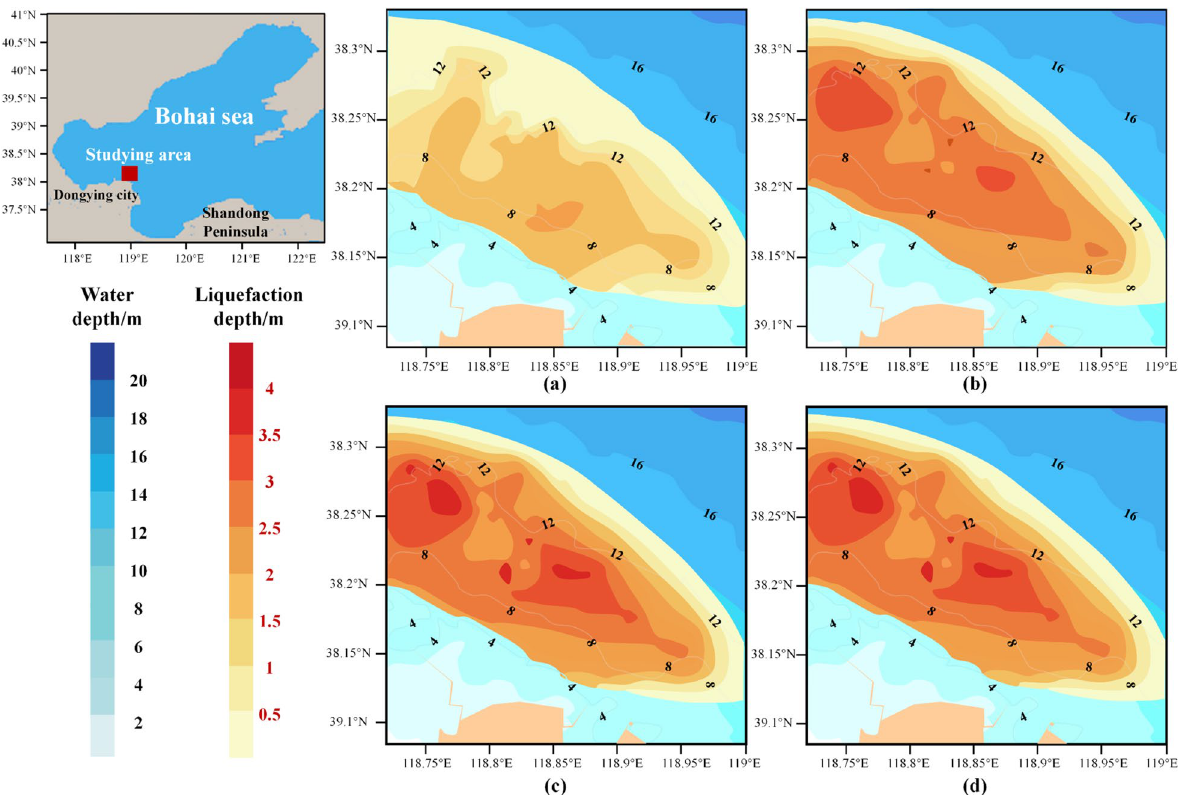
Fig. 13 Potential liquefaction depth of the seabed in different wave recurrence intervals: a wave recurrence period is 2 a; b wave recurrence period is 10 a; c wave recurrence period is 25 a; ( d ) wave recurrence period is 100 a (modified from Du et al.